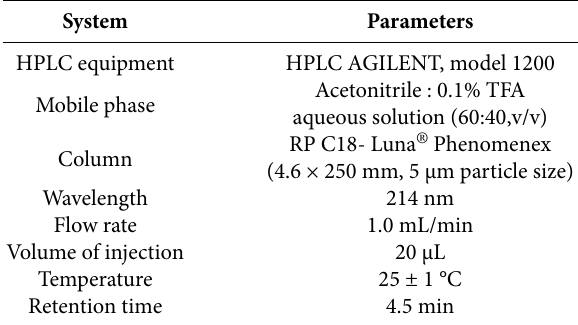
Table 1 . HPLC conditions for determination of insulin in lipos- omes.